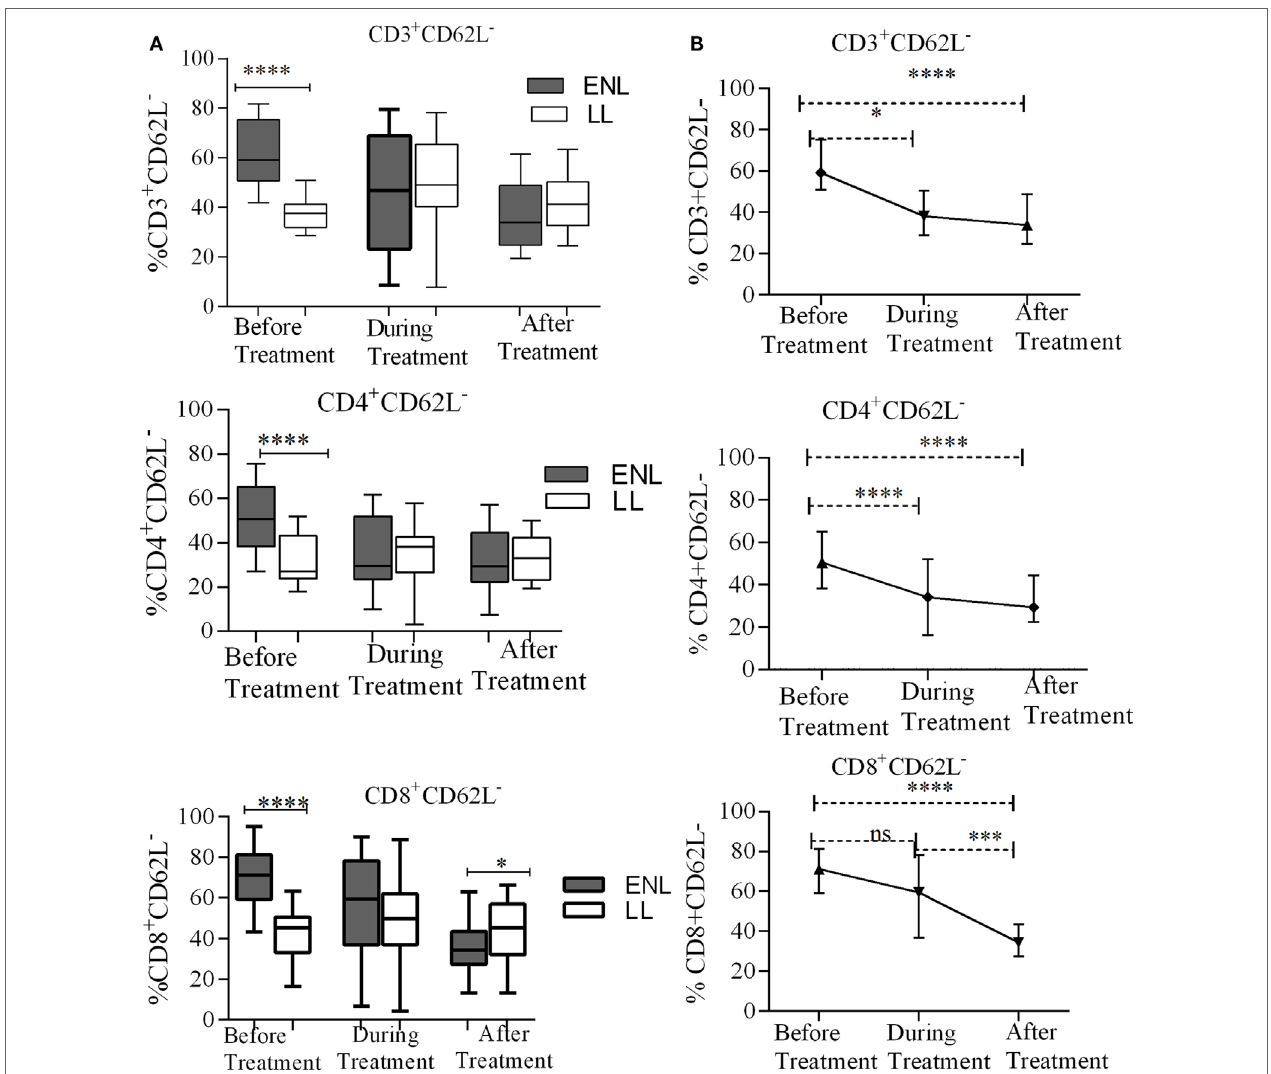
FigUre 2 | Median percentage of total CD3 + , CD4 + , and CD8 + activated T-cells: (a) in patients with erythema nodosum leprosum (ENL) and lepromatous leprosy (LL) controls before, during, and after treatment, (B) within ENL patients before, during, and after treatment. * P ≤ 0.05; *** P < 0.001; **** P < 0.0001. Box and whiskers (a) and error bars (B) show median ± interquartile